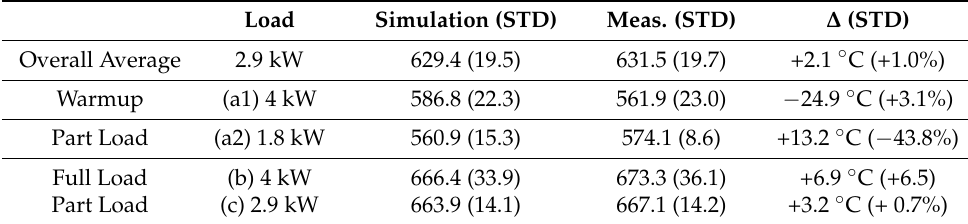
Table 2. Averaged temperatures at the combustion chamber outlet for different loads.